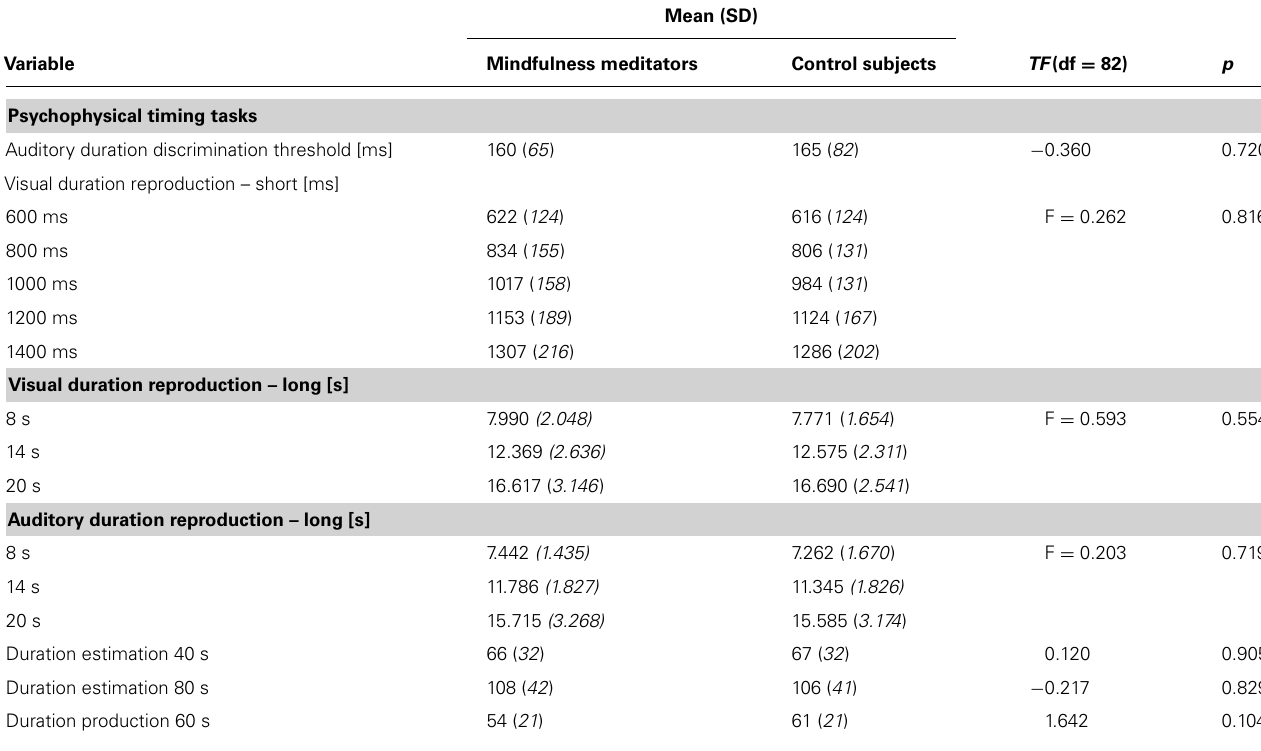
Table 2 | Mean group differences between meditators and control subjects in psychophysical